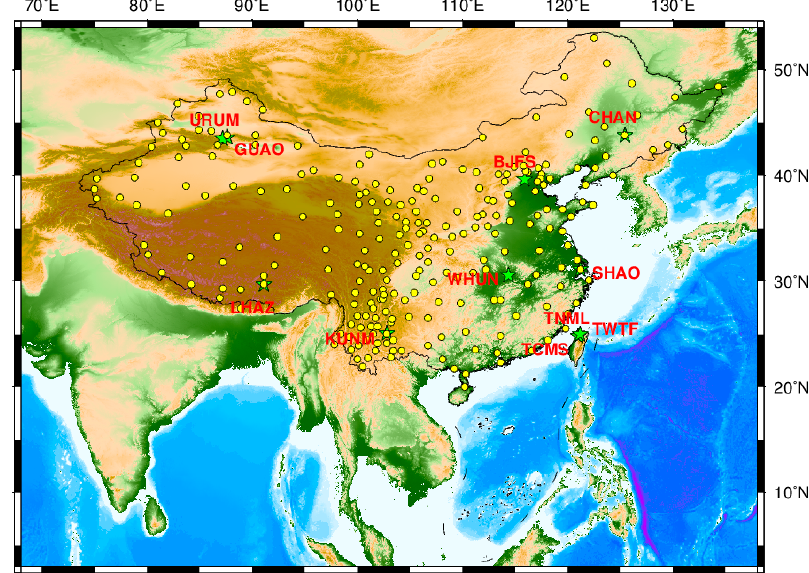
Figure 1. Distribution of IGS and CMONOC stations in China where all the eleven IGS stations are marked in red bold figures.